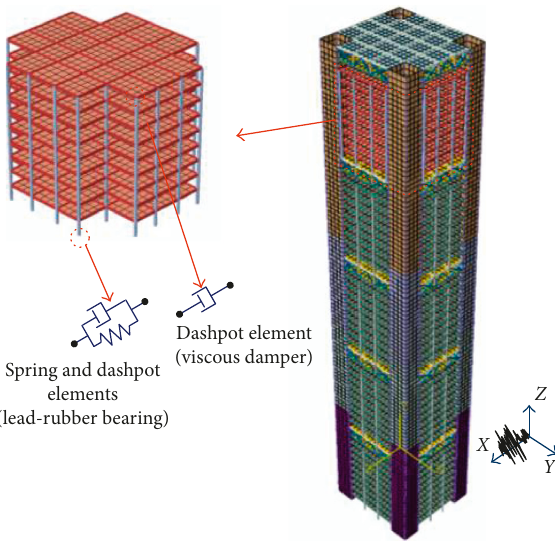
Figure 6: FE model of MFVCS.